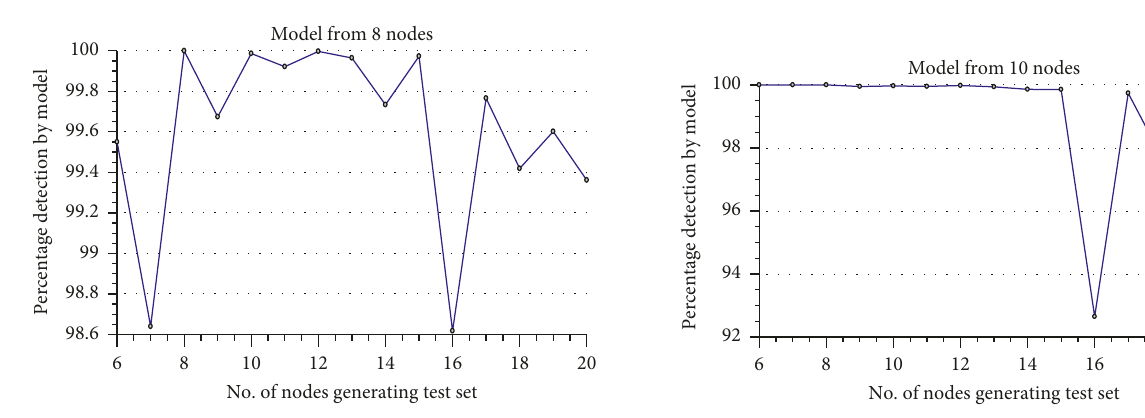
Figure 13: Simulation results for 9 nodes.